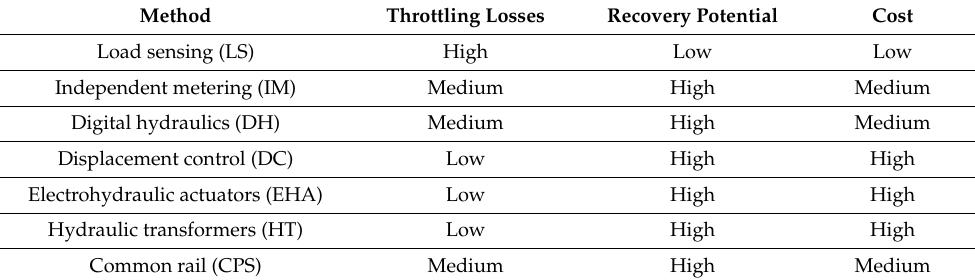
Table 1. Comparison of different methods to reduce the energy demand of a hydraulic